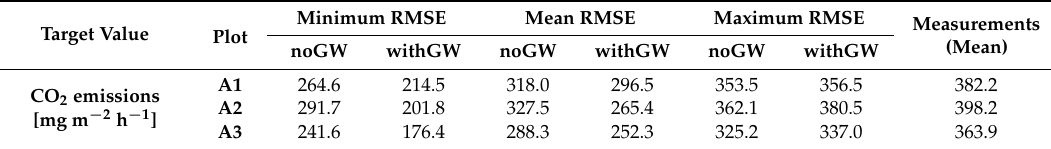
Table 5. RMSE for behavioural simulation runs of CO 2 emission.